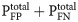
Consensus-based clustering applied to simultaneous intracellular/MEA recordings.a. Band-passed filtered extracellular voltage signal (black) obtained from a multi-electrode array recording (59-electrode MEA, MultiChannel System) performed in vitro in turtle dorsal cortex (Mark Shein-Idelson, Lorenz Pammer, Mike Hemberger and Gilles Laurent, unpublished). One neuron whose spikes could be detected on the MEA was simultaneously recorded intracellularly (*, red). b. Top, Dendrogram obtained by hierarchical clustering with the Single-Link method over the distance matrix defined from the pairwise probability of spike misclassification between final clusters (Pmis, see Methods). Bottom, Pairwise probabilities of spike misclassification between final clusters. c. Whitened spatiotemporal waveforms of 3 of the final clusters identified by consensus-based clustering. We only show the waveforms over six channels centered on the position of maximal amplitude (shaded area). The cluster templates were defined as the average waveform (black). Cluster #1 was identified as the single unit matching the intracellularly recorded cell. The estimated probability of misclassified spikes (PFPtotal+PFNtotal, see Methods) is shown for each cluster. All ground truth spikes were correctly classified (FPrate + FNrate = 0%).